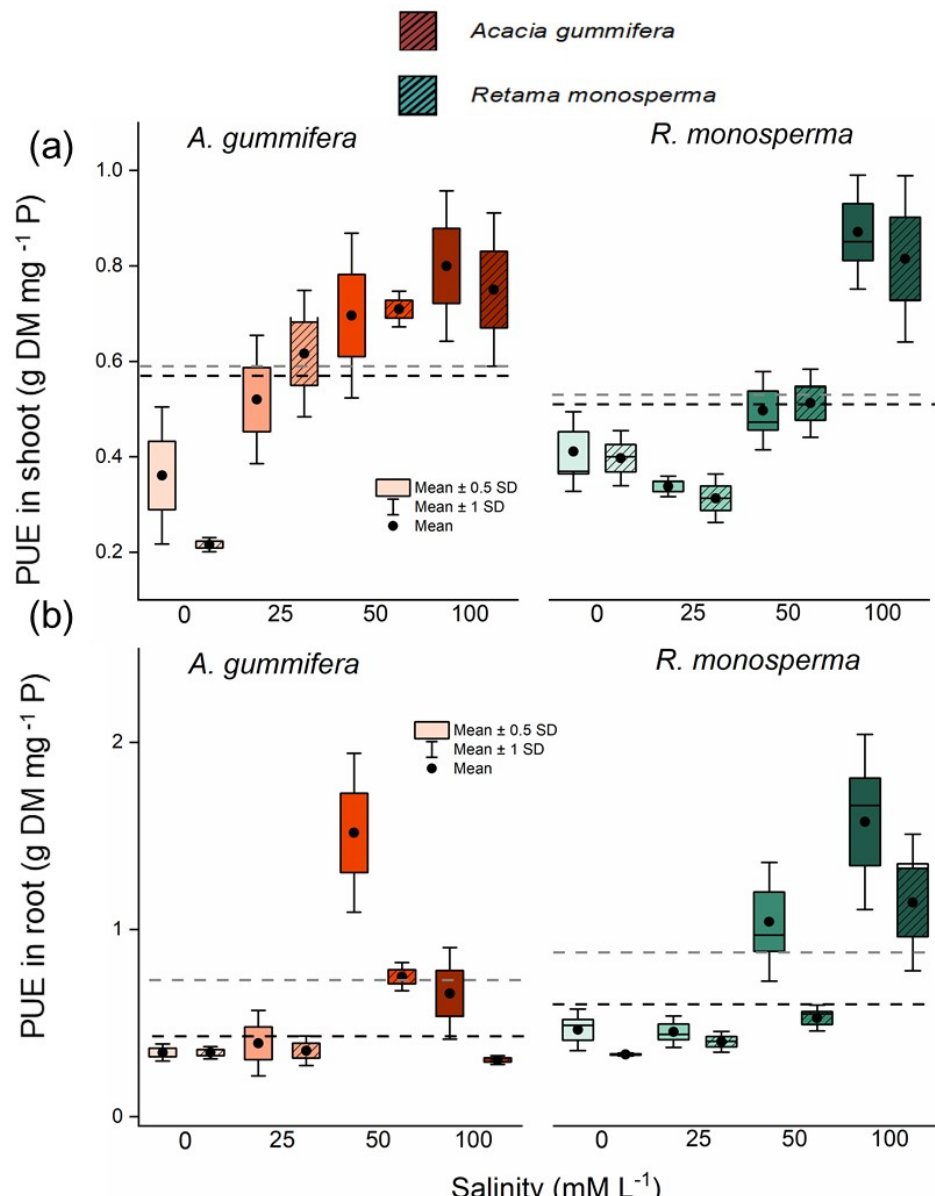
Figure 4. Boxplots of P utilization efficiency (PUE) in the shoot ( a ) and root ( b ) of the non-inoculated and inoculated ( a ) Acacia gummifera and ( b ) Retama monosperma plants grown under different salinity levels (0, 25, 50 and 100 mM NaCl). Mycorrhizal inoculated plants are represented by dashed boxplots. Mycorrhizal inoculated plants are represented by dashed boxplots for both A. gummifera and R. monosperma species. At the different salinity concentration, A. gummifera species are represented by antiwhite and brown colors, and R. monosperma species are shown by tea-green, and green colors, respectively.